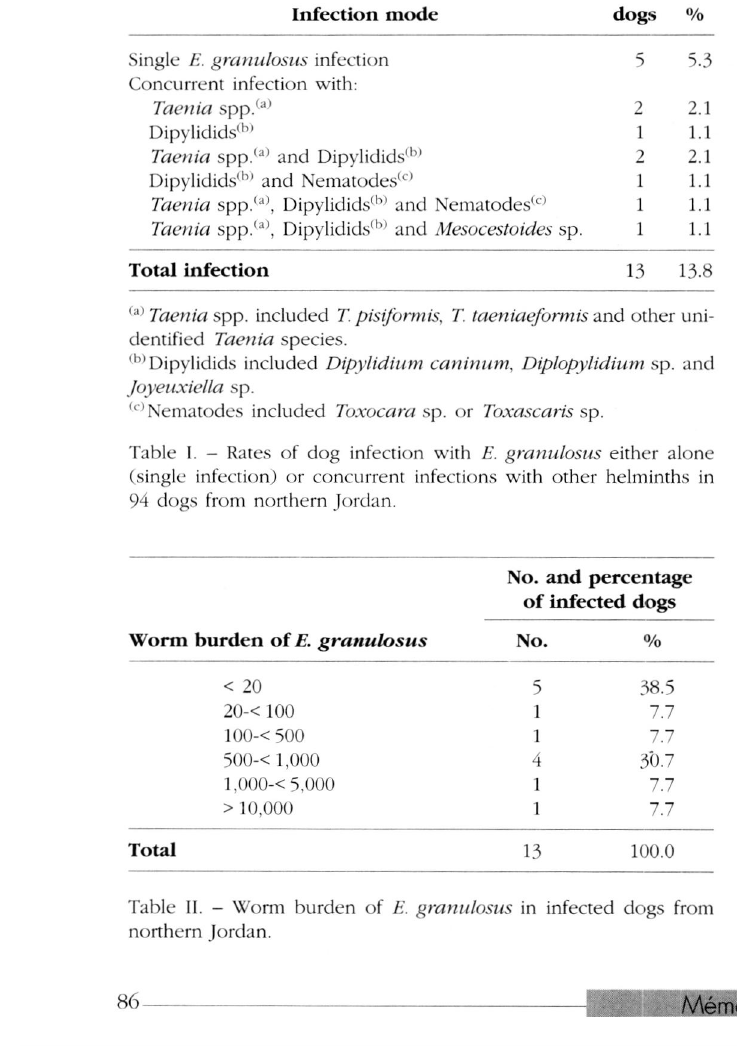
Table II. - Worm burden of E. granulosus in infected dogs from northern Jordan.